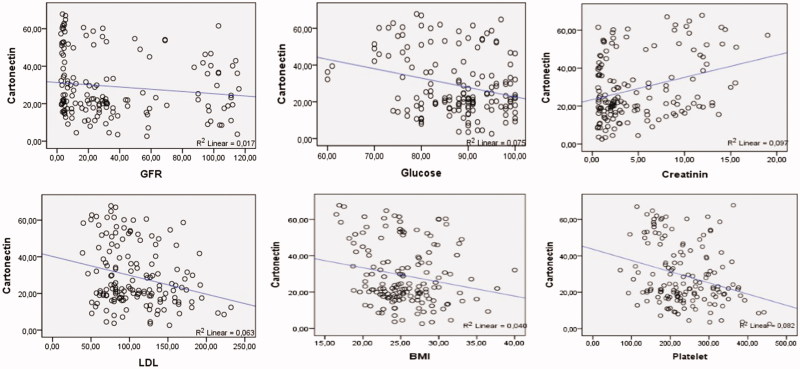
Correlation data.